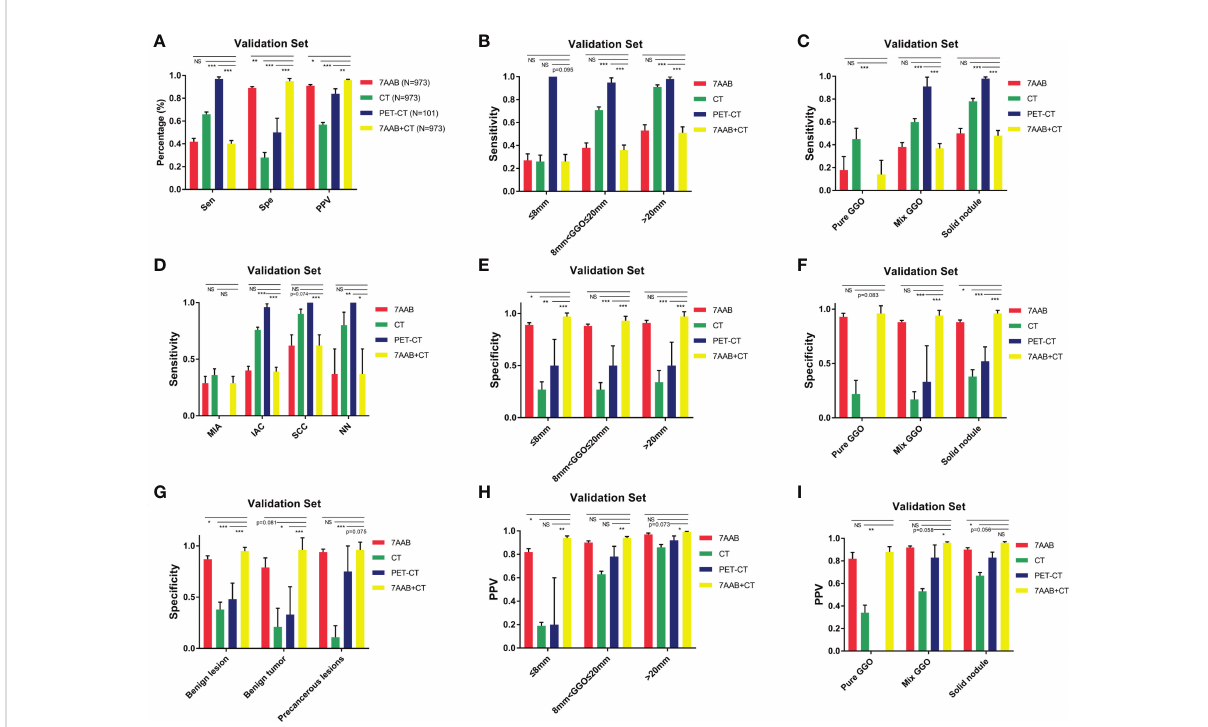
FIGURE 3 diagnostic ef fi ciency of the 7-AAB panel comparing with CT scanning or PET-CT in different subgroups. (A) The sensitivity, speci fi city and PPV of four different diagnostic methods for diagnosing malignant disease in the validation set; (B, E, H) The sensitivity, speci fi city and PPV of four different diagnostic methods for diagnosing malignant disease in different lesion diameter subgroups, respectively; (C, F, I) The sensitivity, speci fi city and PPV of four different diagnostic methods for diagnosing malignant disease in different lesion composition subgroups, respectively; (D) The sensitivity of four different diagnostic methods for diagnosing malignant disease in different pathological type subgroups; (G) The speci fi city of four different diagnostic methods for excluding benign disease in different pathological type subgroups; NS represents no signi fi cant difference;* represents p<0.05; ** represents p<0.01; *** represents